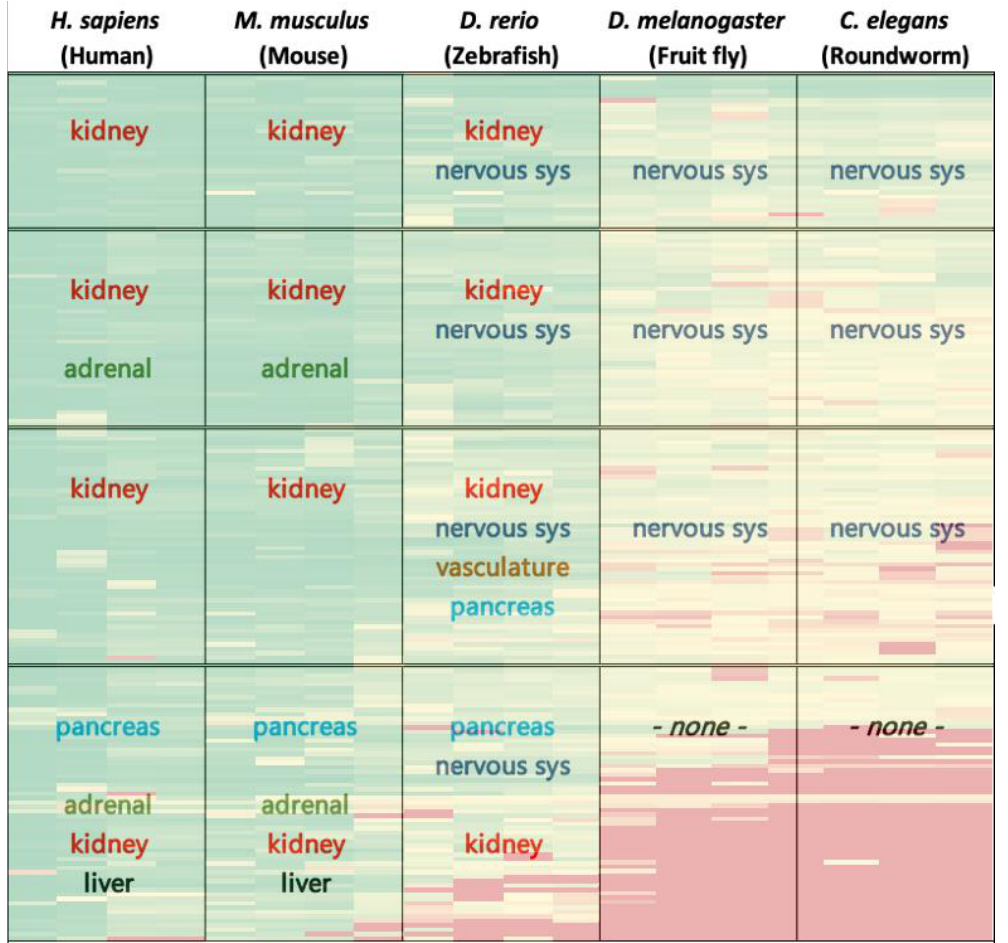
Figure 3. Demonstrates a summary of expression analysis results overlaid on heatmap of Figure 1. In each box, results pertain to the enriched organ/tissue expression for the respective genes-organisms of the cluster. For ease of interpretation, colored text represents tissue/organ types, reflecting their distribution throughout the map. For full functional analysis results please refer to Supplementary Table S2.